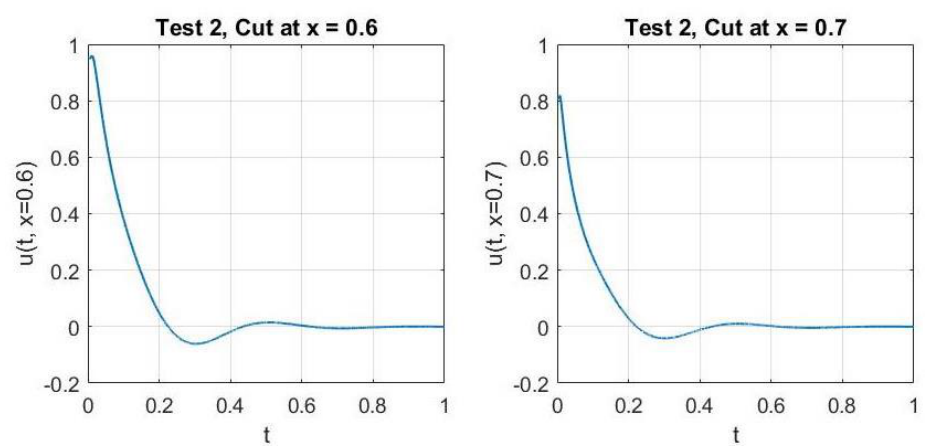
Figure 2. Test 2: The solution u ( t ) of the problem at fixed values of x .